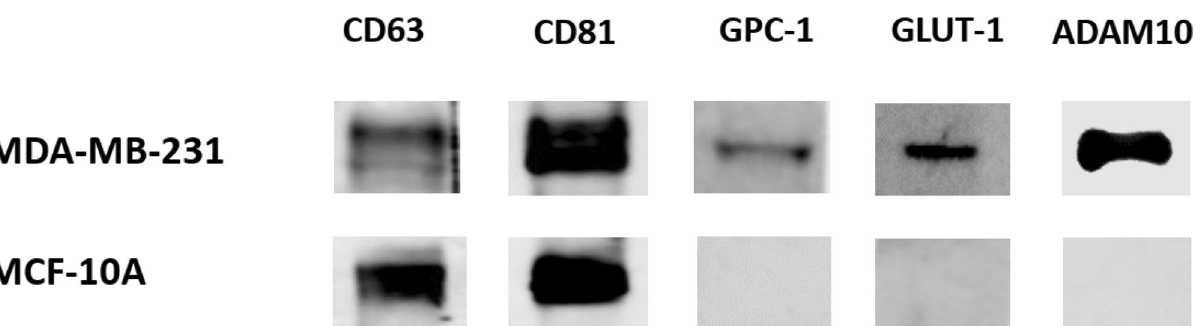
Figure 4. Western blot analysis of CD63, CD81, GPC-1, GLUT-1, and ADAM10 in the exosomes derived from the MDA and MCF cell lines. Full-length gels are shown in Figure